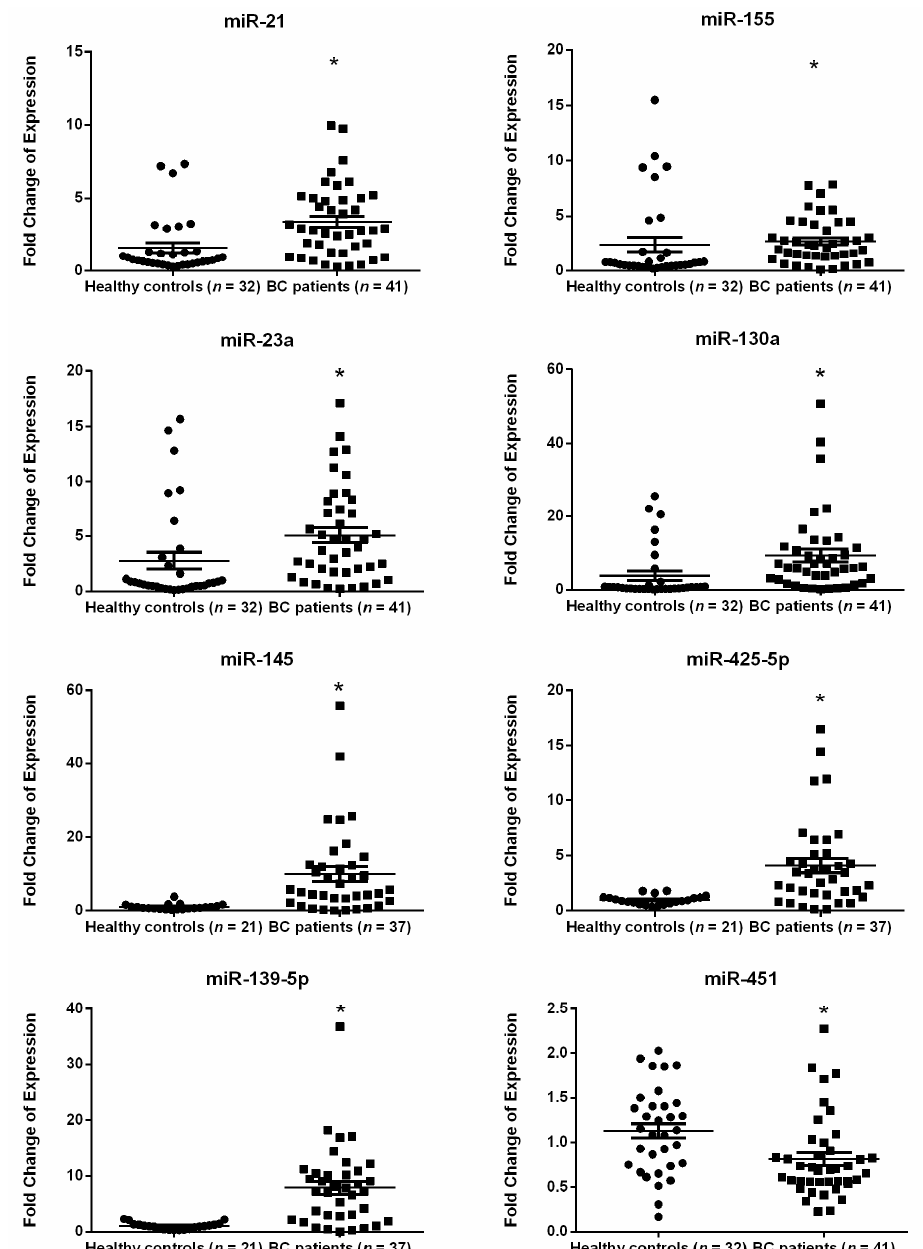
Figure 1. Fold change of expression for the significantly dysregulated miRNA in the plasma of Lebanese women with early ‐ stage BC as compared with healthy controls. The plots represent the mean (middle line) and the standard error of mean (error bars). * Denotes p < 0.05 according to Wilcoxon’s signed ‐ rank test.